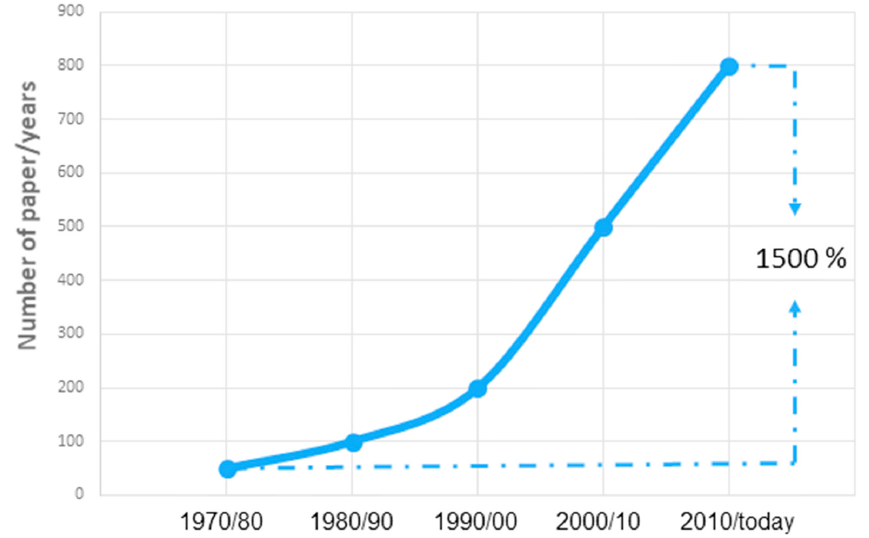
Figure 1. Time evolution of manuscripts published on International Journals having "lifetime prediction" as topic. Source: Scopus (https://www.scopus.com/).